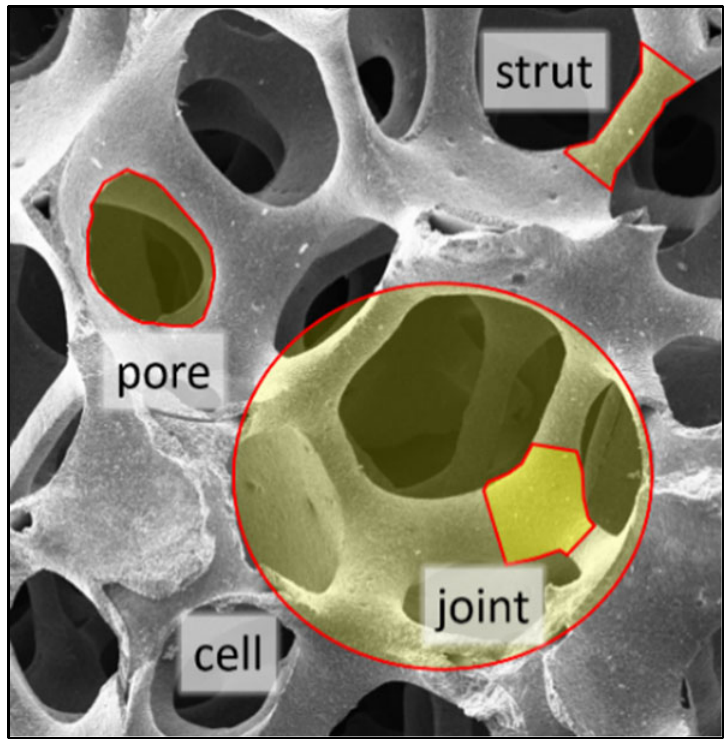
Figure 1. Internal structural elements of open ‐ cell foams.